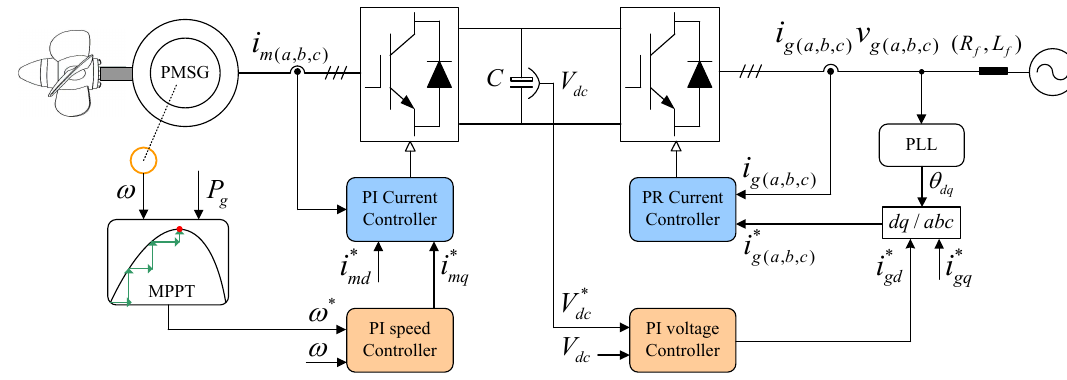
Figure 11. Control design diagram of grid-connected